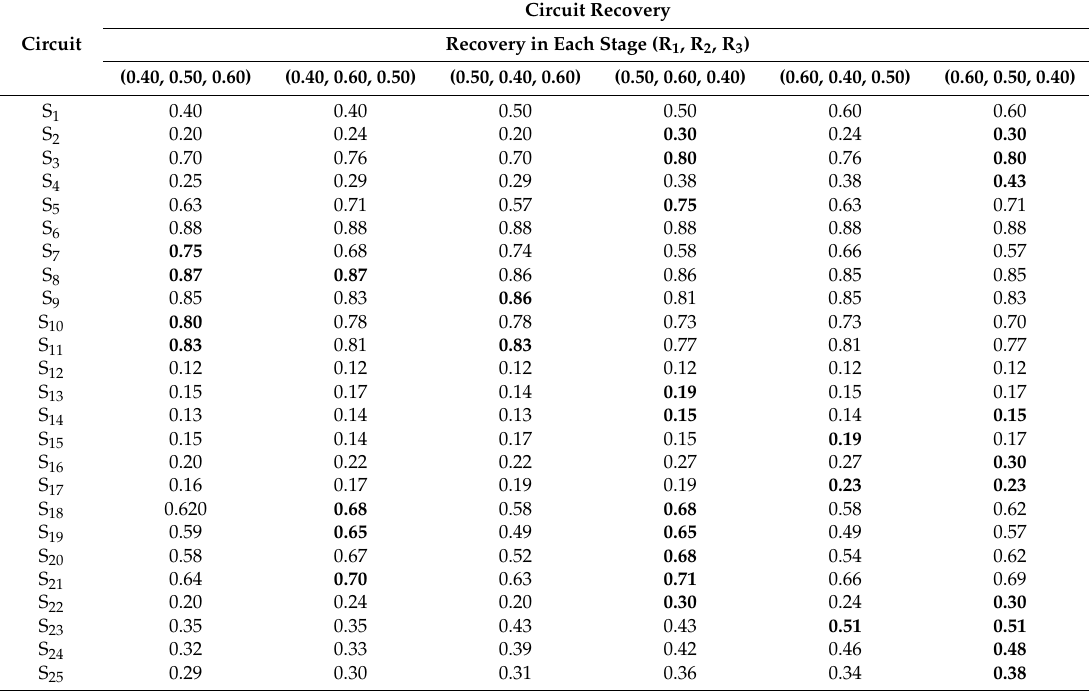
Table 1. Recovery of the circuit with respect to different recovery in the stages (bold numbers are the highest recovery in the